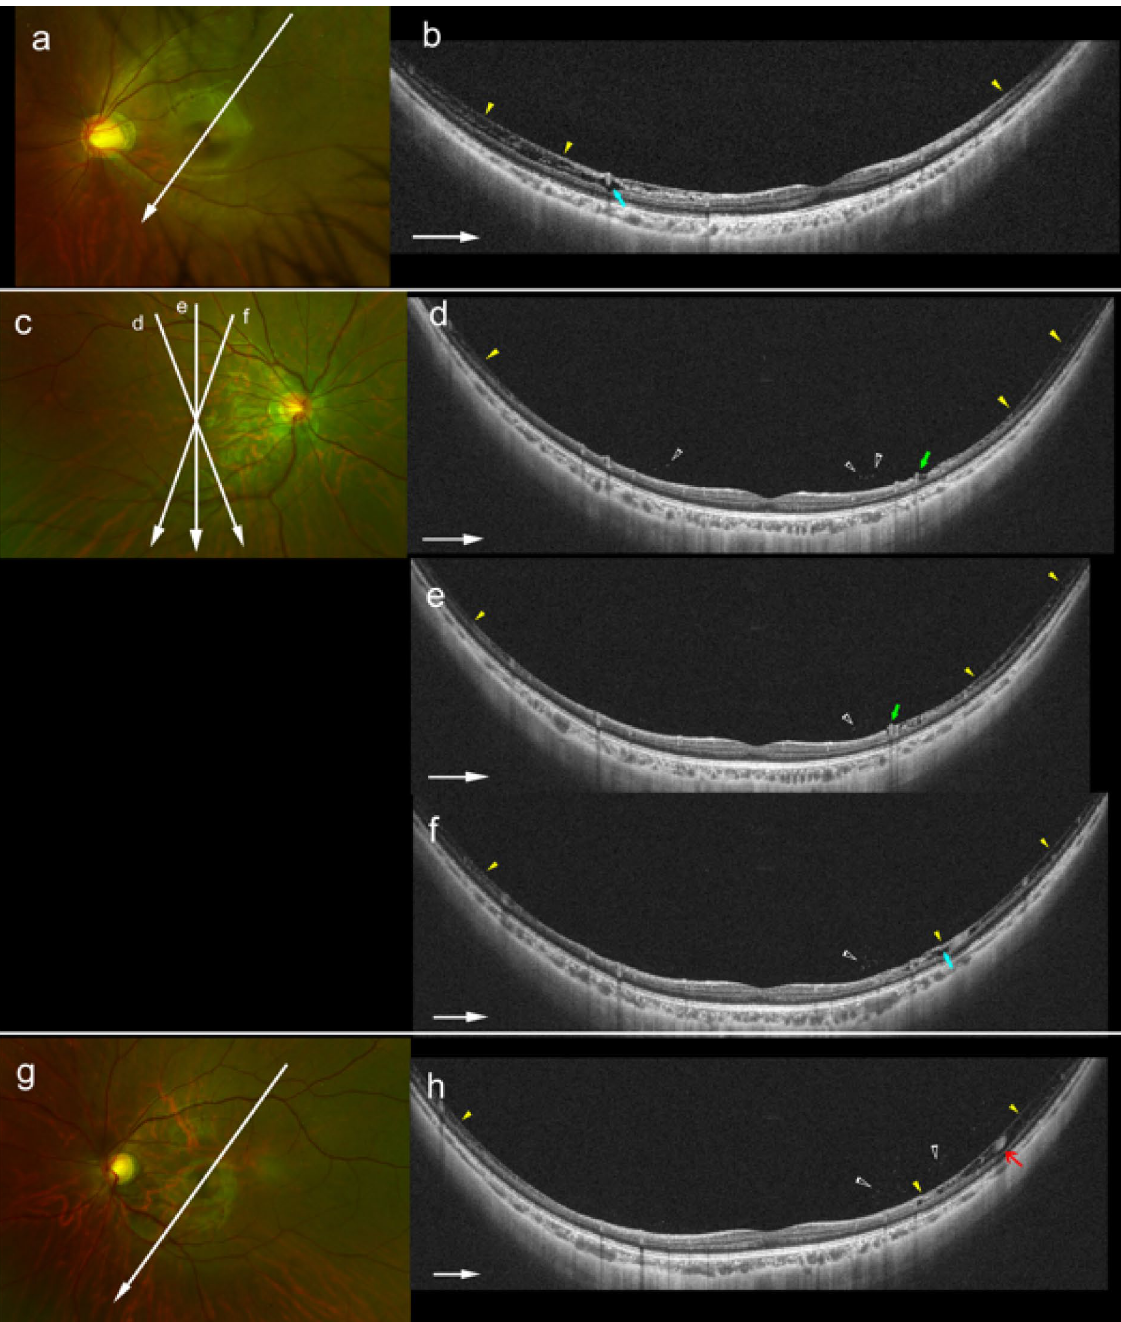
Figure 6. Images showing paravascular retinoschisis (RS) in young highly myopic (HM) eyes. ( a ) Left fundus of a 9-year-old girl with high myopia and refractive error of − 8.0 diopters (D). Arrow shows the line scanned by the ultra-widefield (UWF) OCT. ( b ) UWF-OCT image showing inner RS extending from the paramacular area to the peripheral area on the temporal-superior side of the fovea (arrowheads). Paravascular retinal cysts are present within the area of the RS (arrow). ( c ) Right fundus of a 21-year-old woman with HM and refractive error of − 8.6 D: Arrows show the lines scanned by the UWF-OCT. ( d ) and ( e ) Sequential radial sections of UWF-OCT images showing inner RS extending from the paramacular area to the peripheral area (yellow arrowheads). Intravitreal granular opacities are seen in the paravascular vitreous (open arrowheads). Retinal vessels are lifted up anteriorly (green arrows). ( f ) Paravascular retinal cysts are seen within the area of RS (light blue arrow). ( g ) Left fundus of the same patients as in ( c ). Refractive error is − 8.9 D in the left eye. ( h ) Oblique UWF-OCT image showing inner RS extending from the paramacular area to the peripheral area (yellow arrowheads). Intravitreal opacities are present within the paravascular vitreous (open arrowheads). Retinal vessel is surrounded by paravascular RS (red